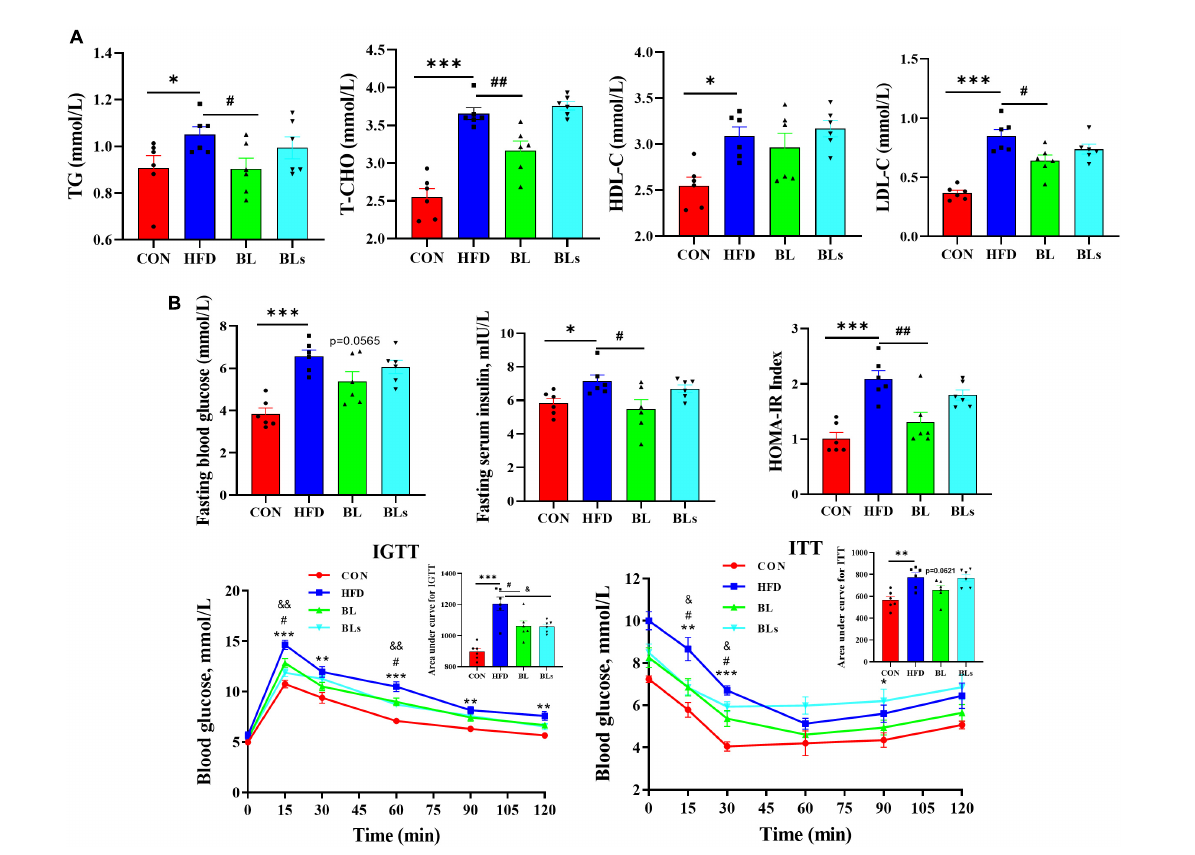
FIGURE2 Brevibacillus laterosporus BL1 treatment improved serum lipid profile and insulin resistance in HFD-fed mice. (A) Serum concentrations of TG, T-CHO, HDL-C, and LDL-C, (B) serum concentrations of fasting blood glucose and insulin, IGTT and ITT, curves of blood glucose levels, and the calculated area under curve values. Data are presented as mean ± SEM ( n = 6) and analyzed using one-way ANOVA. Significant differences between HFD and CON are indicated by ∗ p < 0.05 and ∗∗∗ p < 0.001. Significant differences between HFD and BL are indicated by # p < 0.05 and ## p < 0.01. Significant differences between HFD and BLs are indicated by & p <